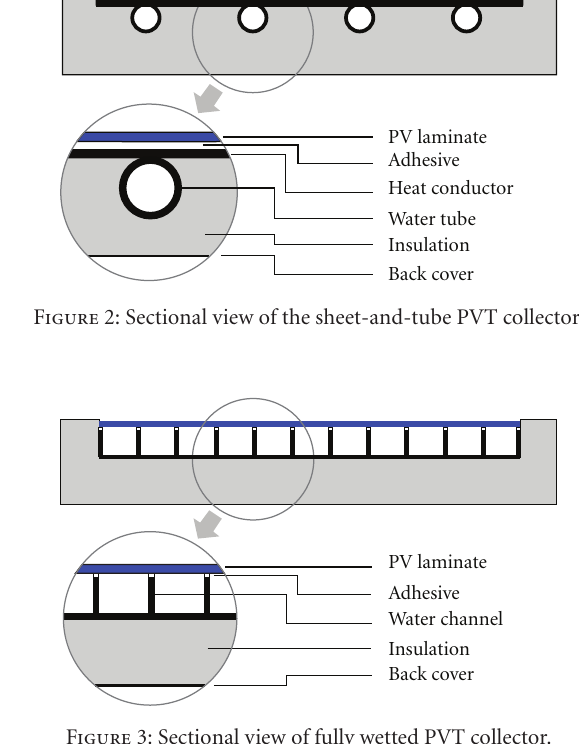
Figure 3: Sectional view of fully wetted PVT